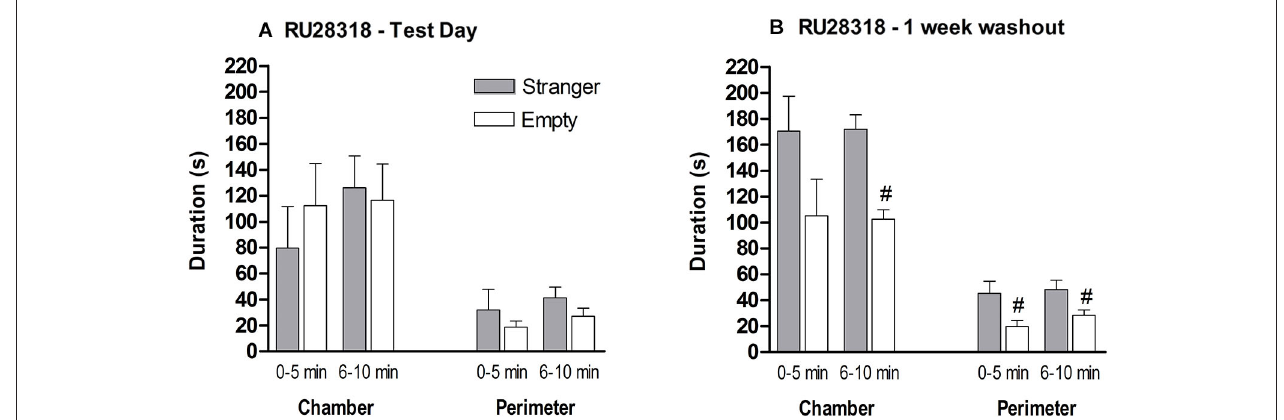
around the cylinder. (B) One week later the mice were tested again on time spent in the chamber and perimeter with a new set of strangers. # p < 0.05 compared to the stranger chamber/perimeter. All data are expressed as mean ± S.E.M.